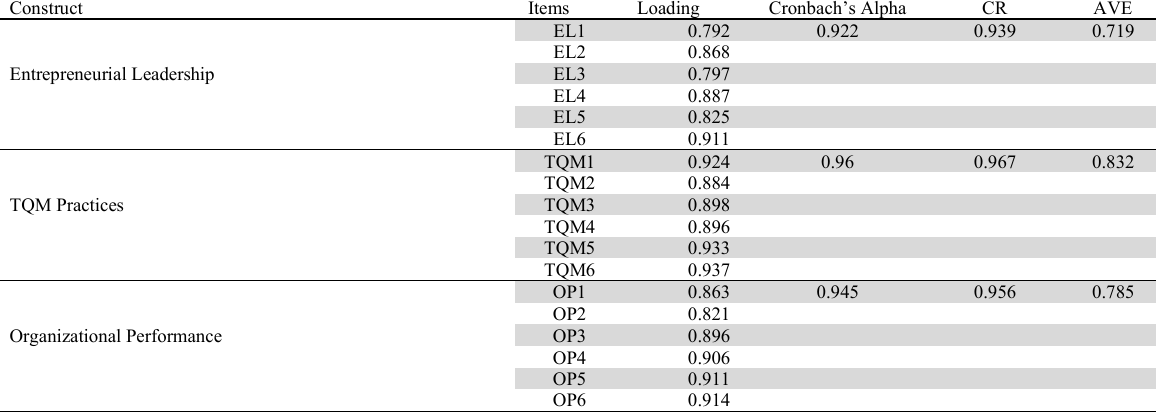
Convergent validity, Cronbach's alpha, Composite Reliability (CR), AVE